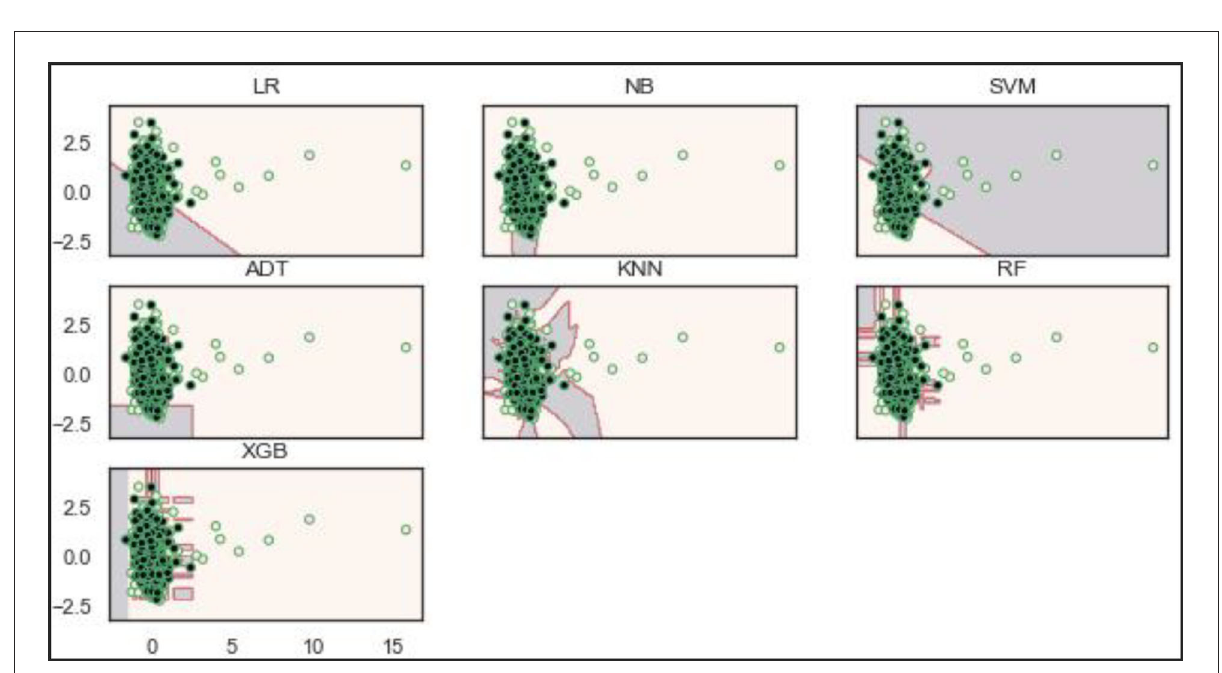
FIGURE12 Decision boundaries of the models on the balanced dataset.